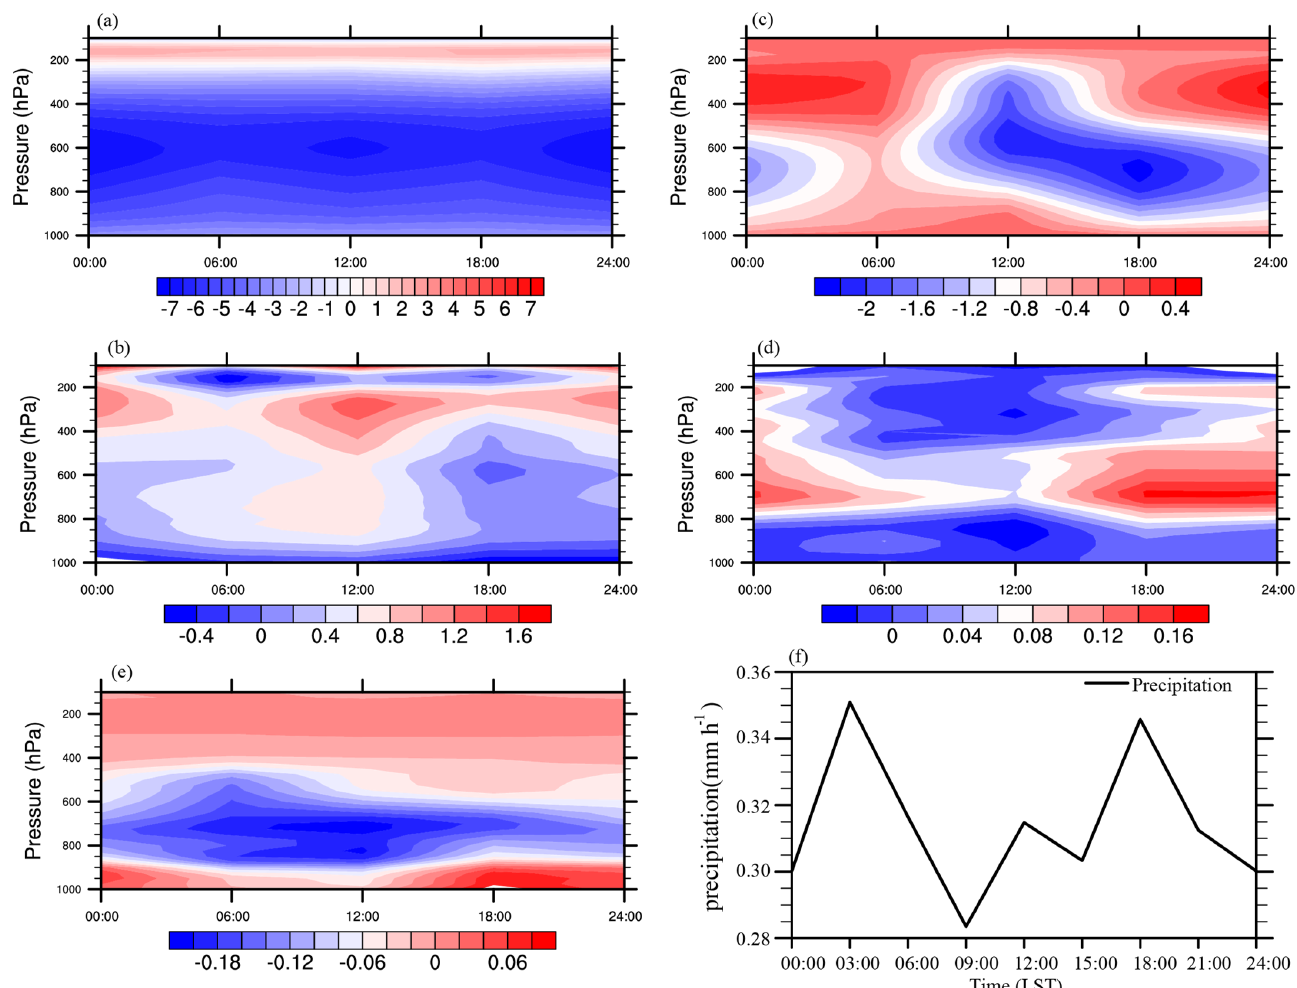
Figure 3. Diurnal composite of the large-scale forcing variables in the KWAJEX data: ( a ) large − scale zonal (ms − 1 ), ( b ) meridional (m s − 1 ), and ( c ) vertical (hPa h − 1 ) components of the velocity; ( d ) horizontal temperature advection (10 − 1 K h − 1 ), and ( e ) horizontal advection of the water vapor mixing ratio (10 − 1 g kg − 1 h − 1 ); and ( f ) precipitation using the three − hourly rainfall (mm) from TRMM 3B42 data.